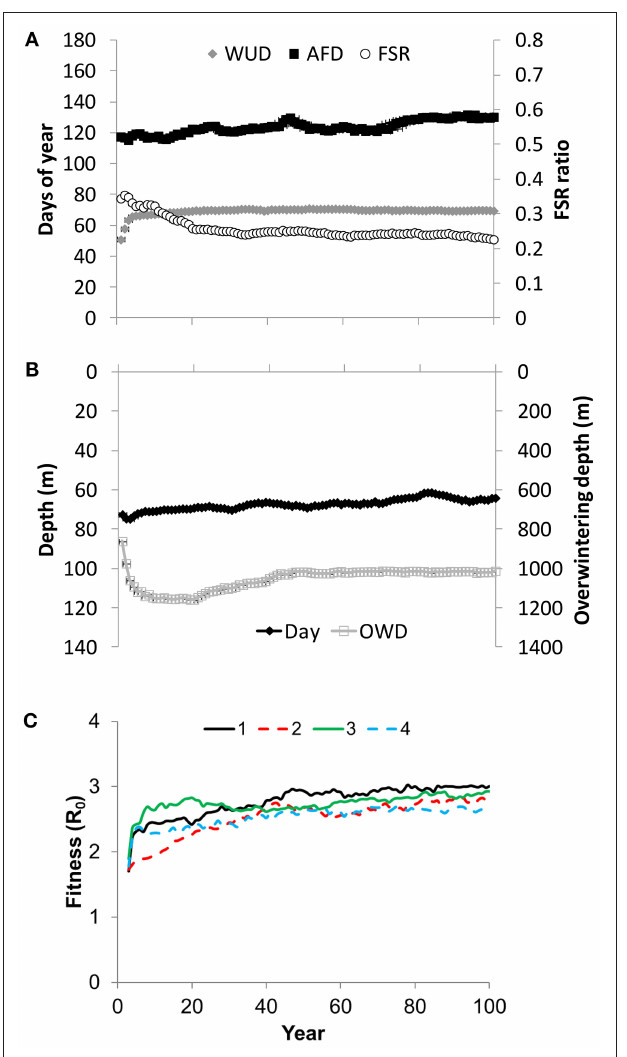
FIGURE 4 | The development over 100 years of the best replicate in simulation 2 in (A) wake up day (WUD), allocation to fat day (AFD) and fat to soma ratio (FSR) traits, (B) the day depth (DD) and overwintering depth (OWD), and (C) fitness (the net reproductive rate, R0) of all four replicates. Values are from end of each